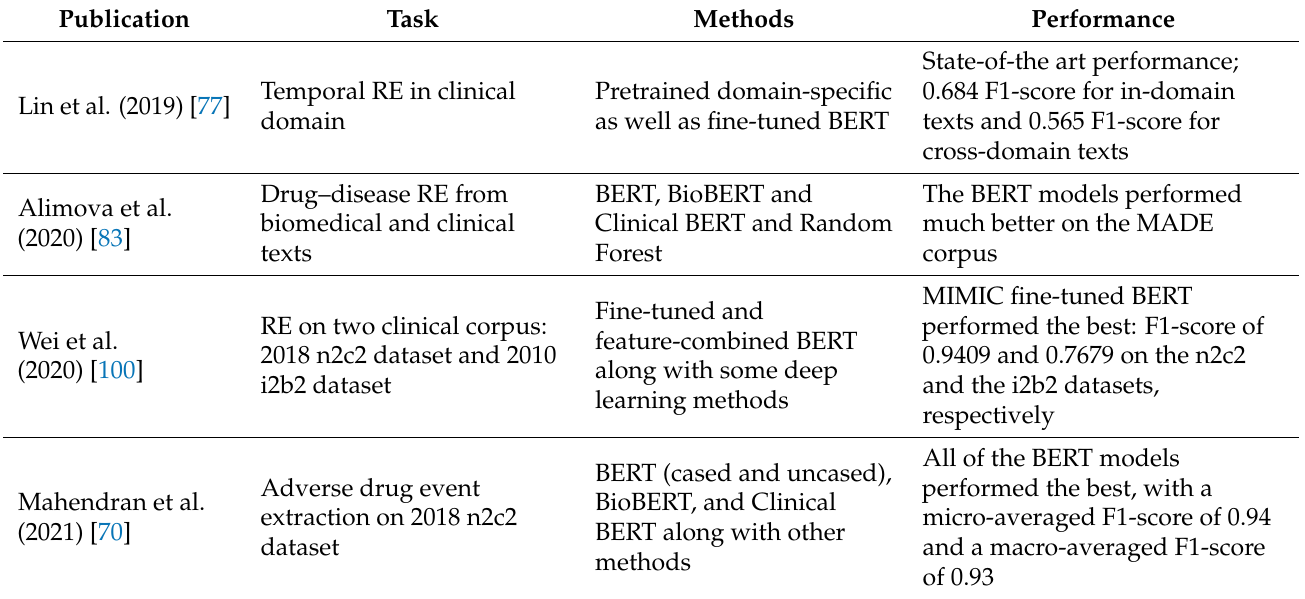
Table A5. Summary of the language model-based approaches for clinical RE.